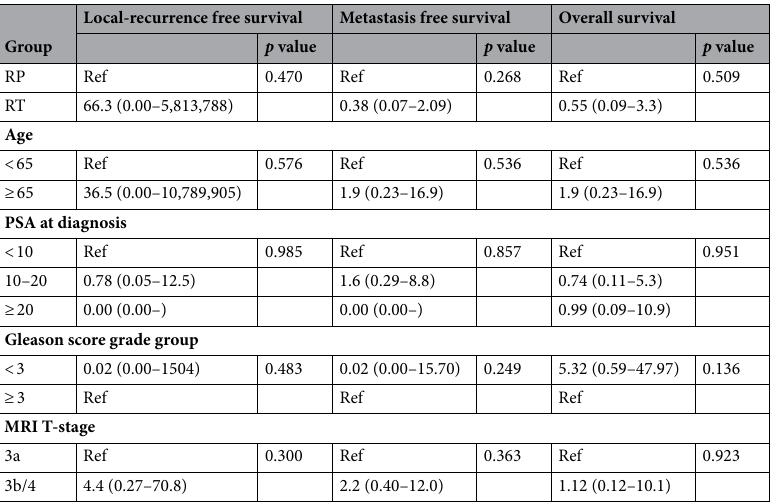
Table 3. Cox regression univariate analysis for local-recurrence free survival, metastasis free survival and overall survival in propensity score-matched patients. Cox proportional hazards models with 95% confidence interval were used to analyze the relationships between clinical variables and oncologic outcomes including local recurrence, metastasis and overall survival. Two-sided p values were calculated and a level of < 0.05 was considered statistically significant. RP radical prostatectomy, RT